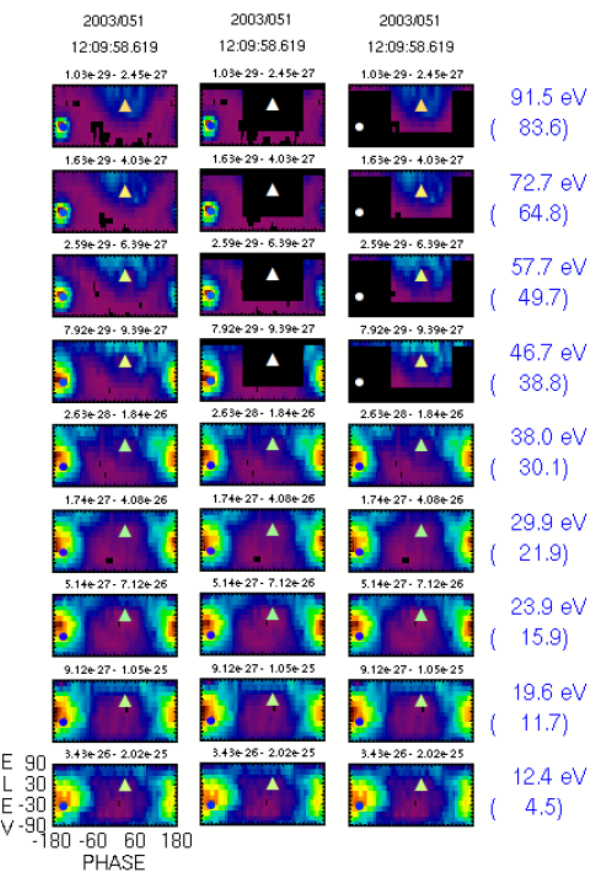
Fig. 3. A set of phi/theta plots illustrating how various volumes in phase space (s 3 cm − 6 ) can be defined to isolate specific populations of